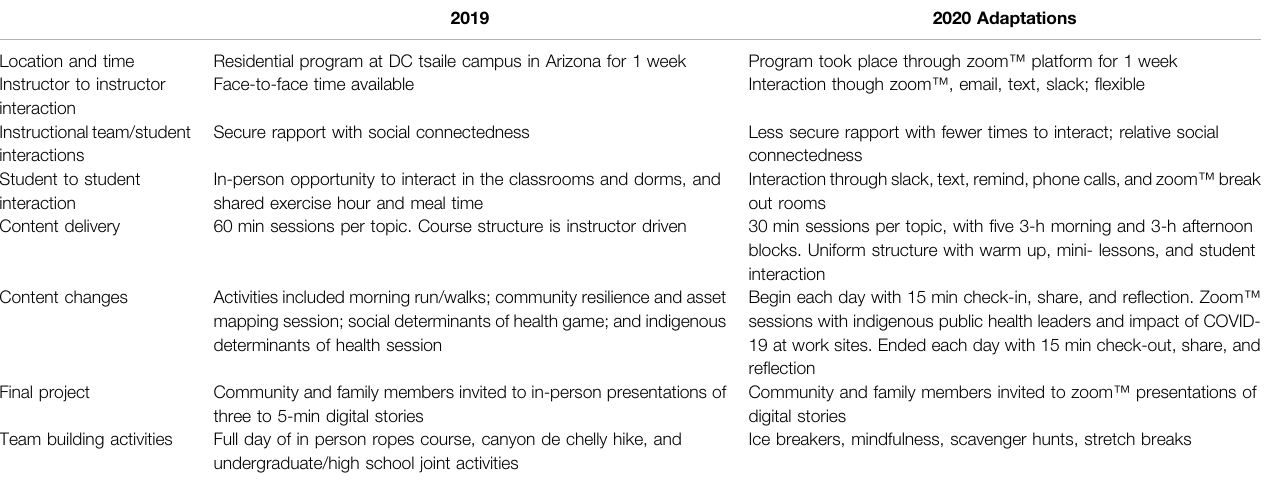
TABLE 1 | Indigenous Summer Enhancement Program adaptions for